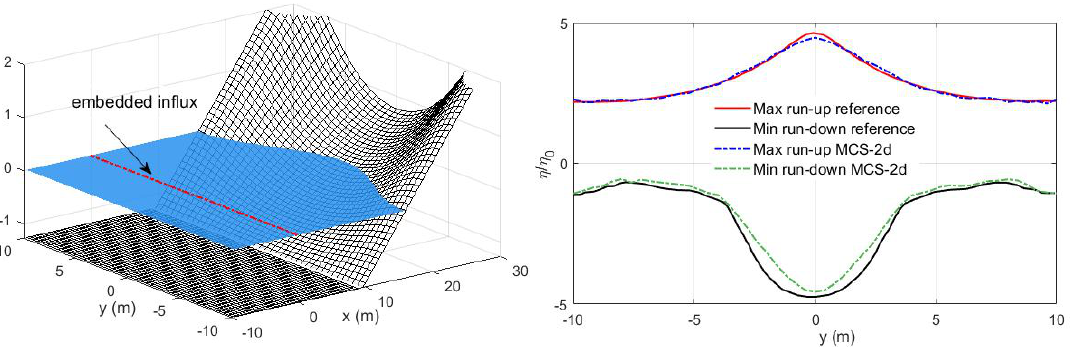
Figure 6. ( Left ) Bathymetry of a sloping bay and the still water level. The red line indicates the embedded influx line. ( Right ) Maximum run-up and run-down at the beach calculated using MCS-2d scheme in comparison with those of Özkan and Kirby, 1997